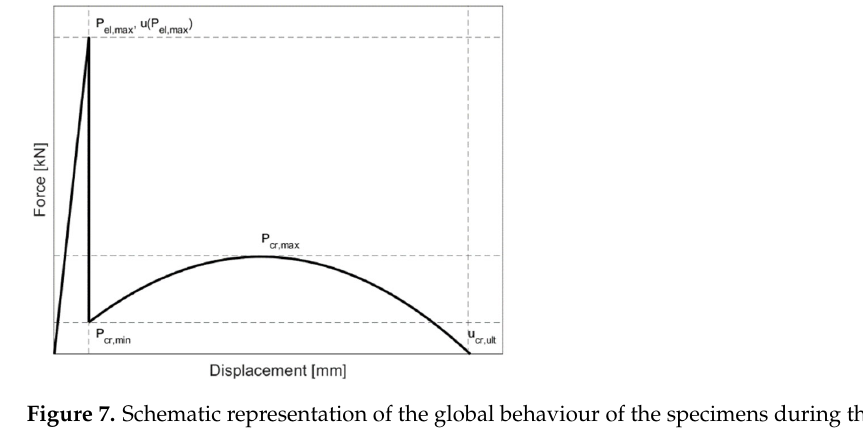
stage of the behaviour, while the notation cr indicates the post ‐ elastic (cracked) phase.